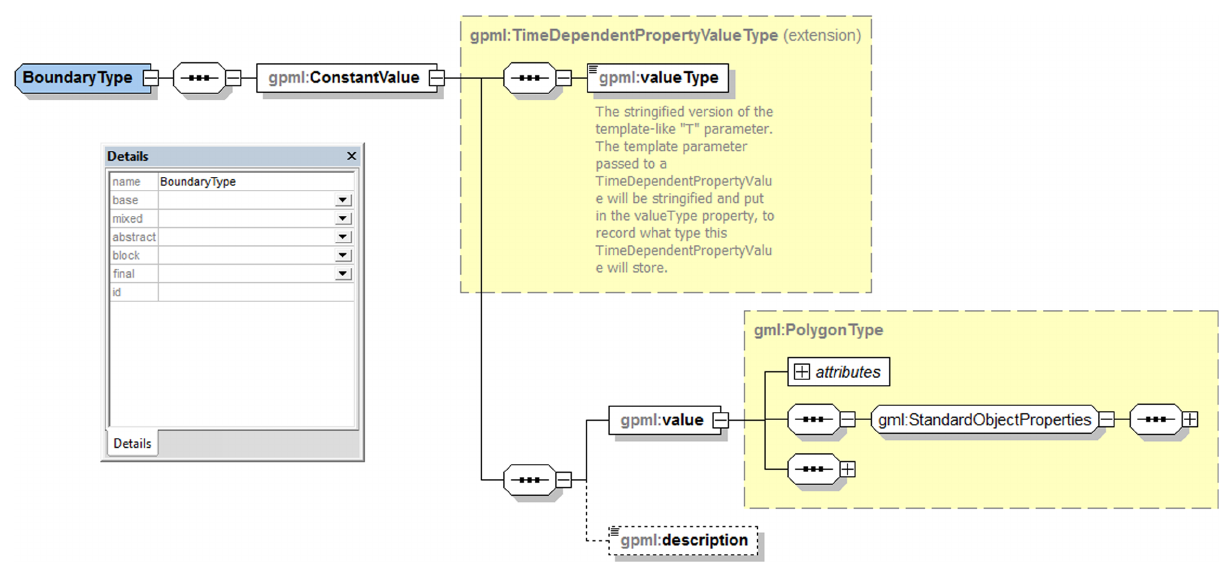
Fig. 19. The boundary geometry schema diagram in